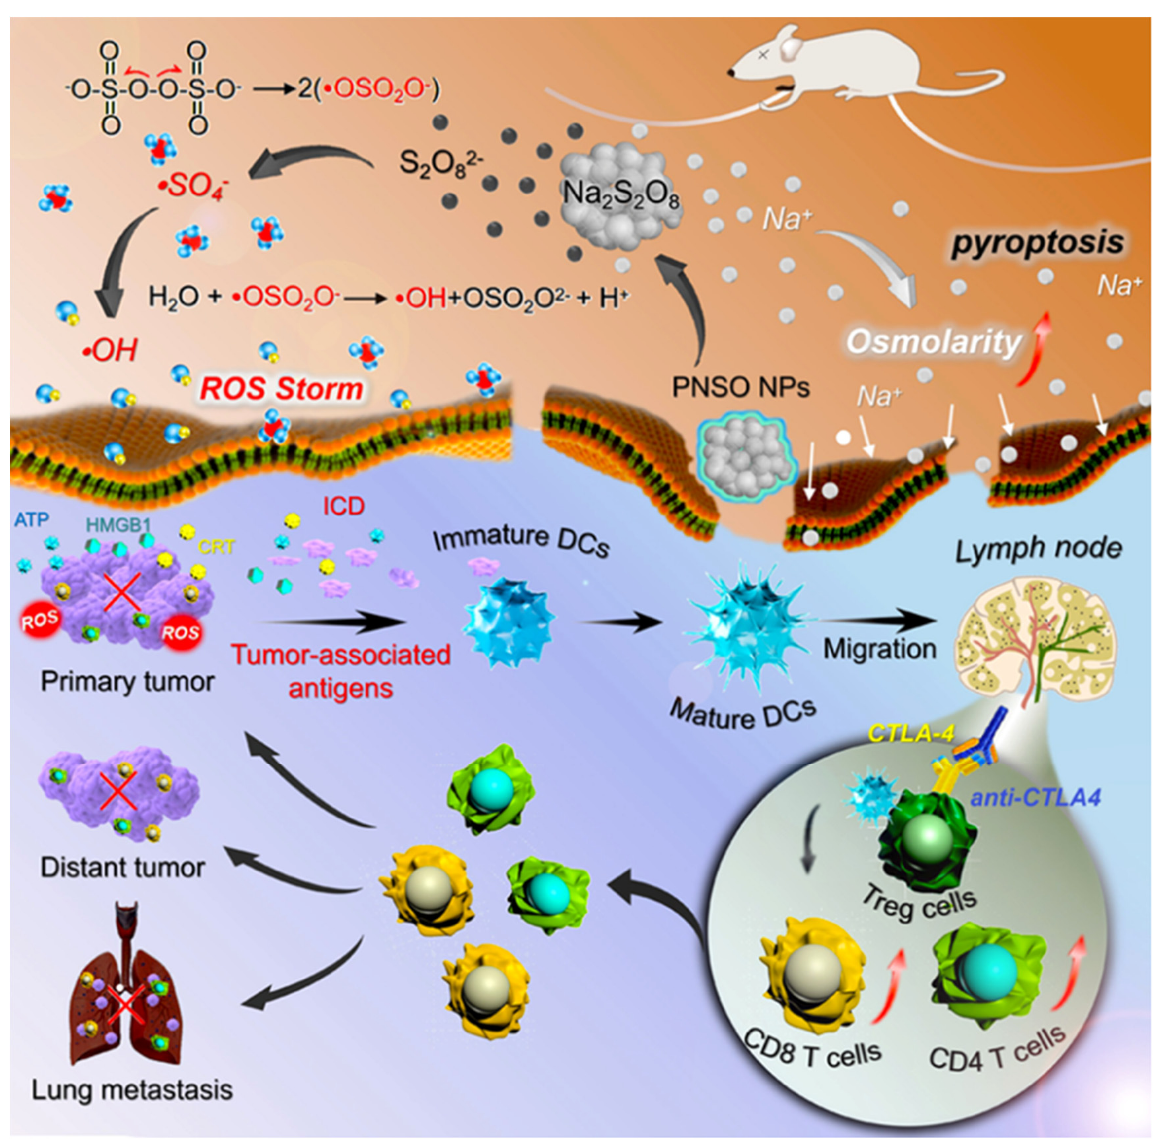
Figure 4. Scheme of therapeutic efficacy and mechanism of ROS-responsive Na 2 S 2 O 8 nanoparticles. Reprinted with permission from Ref. [39]. Copyright 2020, Zhang, H.